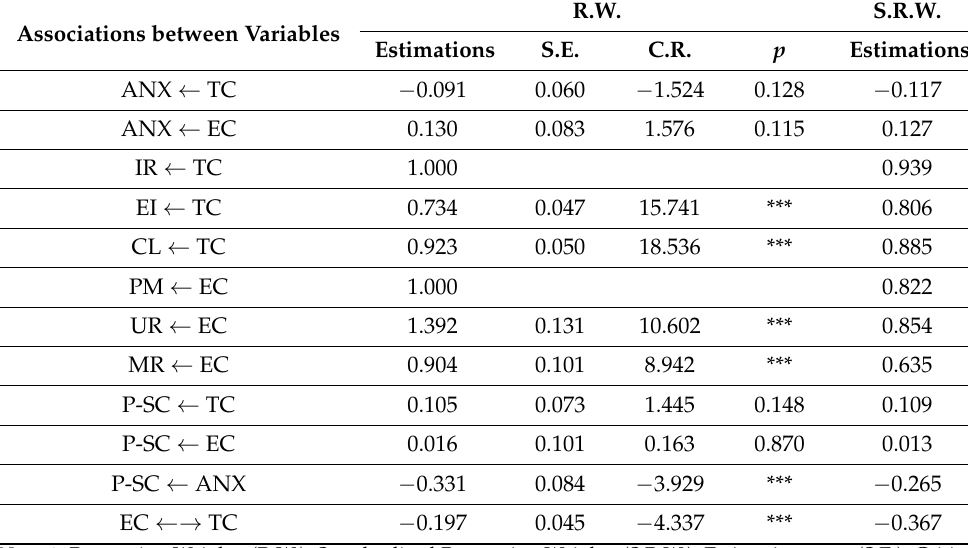
Table 3. Structural model for medium adherence to the Mediterranean diet. Associations between Variables